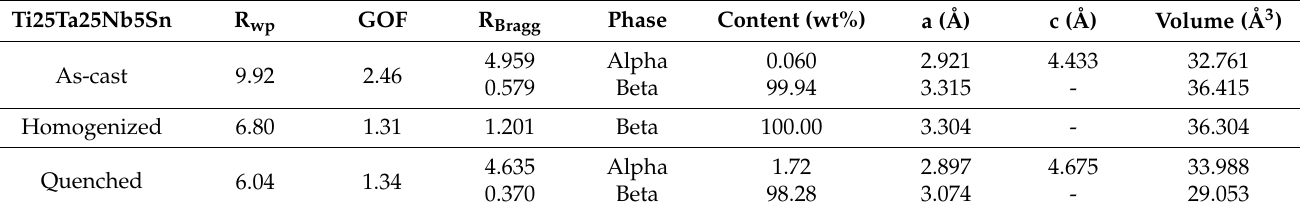
Figure 1. Rietveld refinement of the X-ray diffraction pattern of the Ti-25Ta-25Nb-5Sn alloy. The analysis was carried out after each processing step of the alloy: as cast, after homogenization heat treatment, and after quenching. The blue lines represent the observed XRD data. The black lines represent data calculated by Rietveld refinement. The gray lines represent the difference between the observed data and data calculated by Rietveld refinement. The diamond represents the X-ray diffraction pattern of the alpha phase, according to reference ICSD 99778. The triangle represents the X-ray diffraction pattern of the beta phase, according to reference ICSD 76165. Table 1. The concentrations of the phases and lattice parameters were obtained by Rietveld